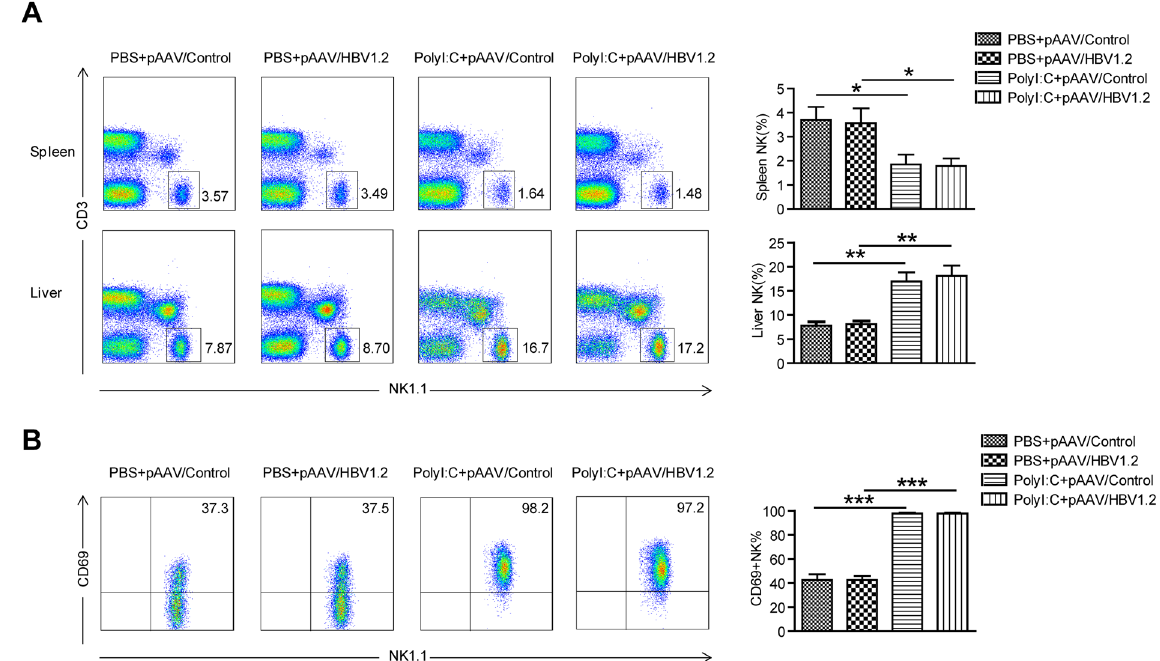
Figure 4. PolyI:C treatment activates NK cells and induces accumulation of NK cells in the liver. Mice were injected with HBV plasmid or control plasmid and chronically treated with Poly I:C as described in Materials and Methods. Lymphocytes were isolated from the liver and spleen and analyzed by flow cytometry. ( A ) The percentages of NK cells (CD3-NK1.1 + ) were analyzed using anti-NK1.1 and anti-CD3 antibodies. ( B ) The surface expression of CD69 on gated NK cells (CD3-NK1.1 + ) was also analyzed. Data are shown as mean ± SEM; ** p < 0.01, *** p < 0.001. n = 4–5 in each